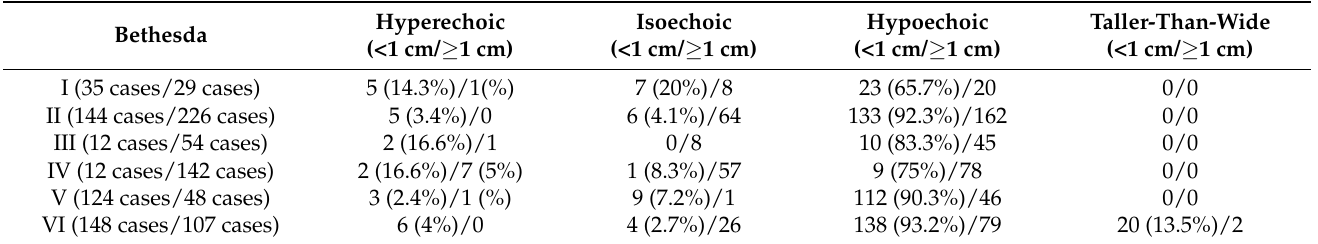
Table 2. US echogeneity stratified according to FNAC diagnostic categories (subcentimeter/equal to or larger than 1 cm